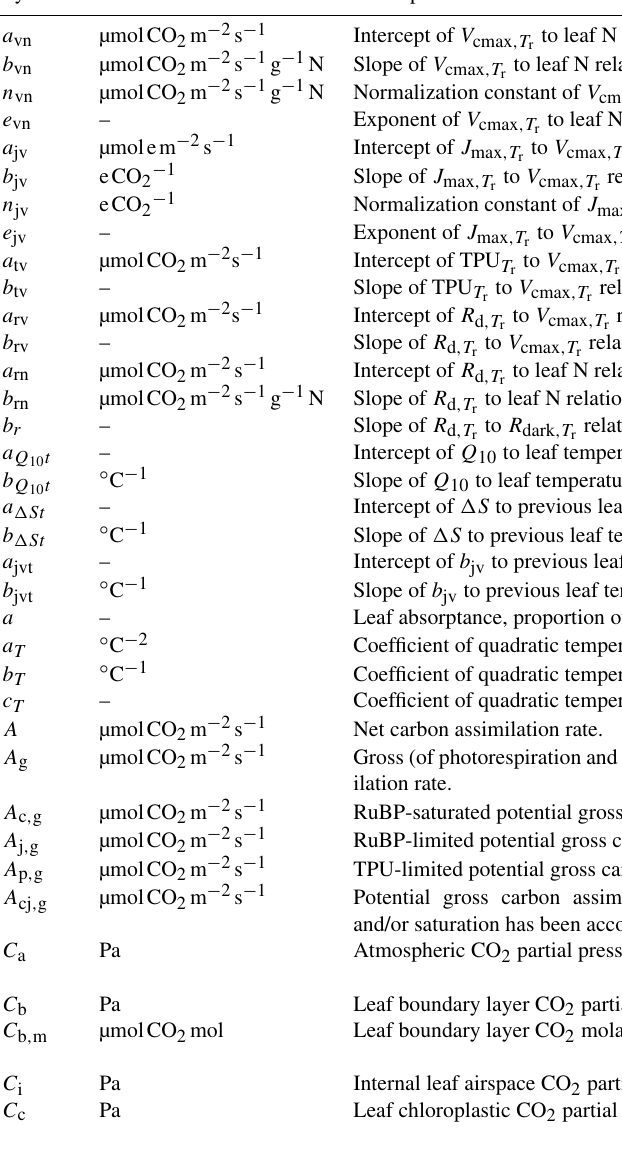
RuBP-saturated potential gross carbon assimilation